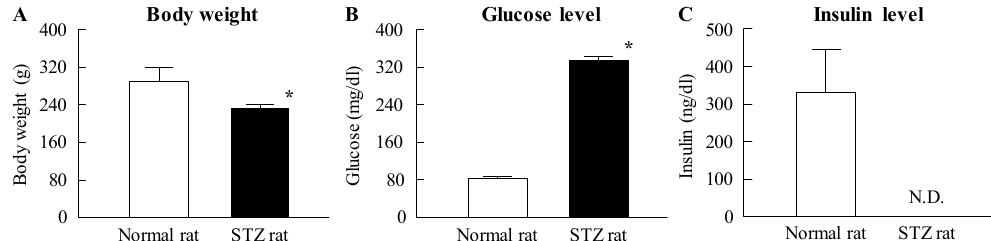
Figure 2. Body weight ( A ), plasma glucose ( B ), and plasma insulin ( C ) in normal and streptozotocin (STZ) rats. STZ rats were used two weeks after the injection of streptozotocin; blood was collected at 10:00 a.m. Open columns, normal rats; closed columns, STZ rats. n = 6. N.D., not detectable. * p < 0.05, vs. normal rat for each category. Hyperglycemia and hypoinsulinemia were observed in STZ rats two weeks after the injection of streptozotocin.